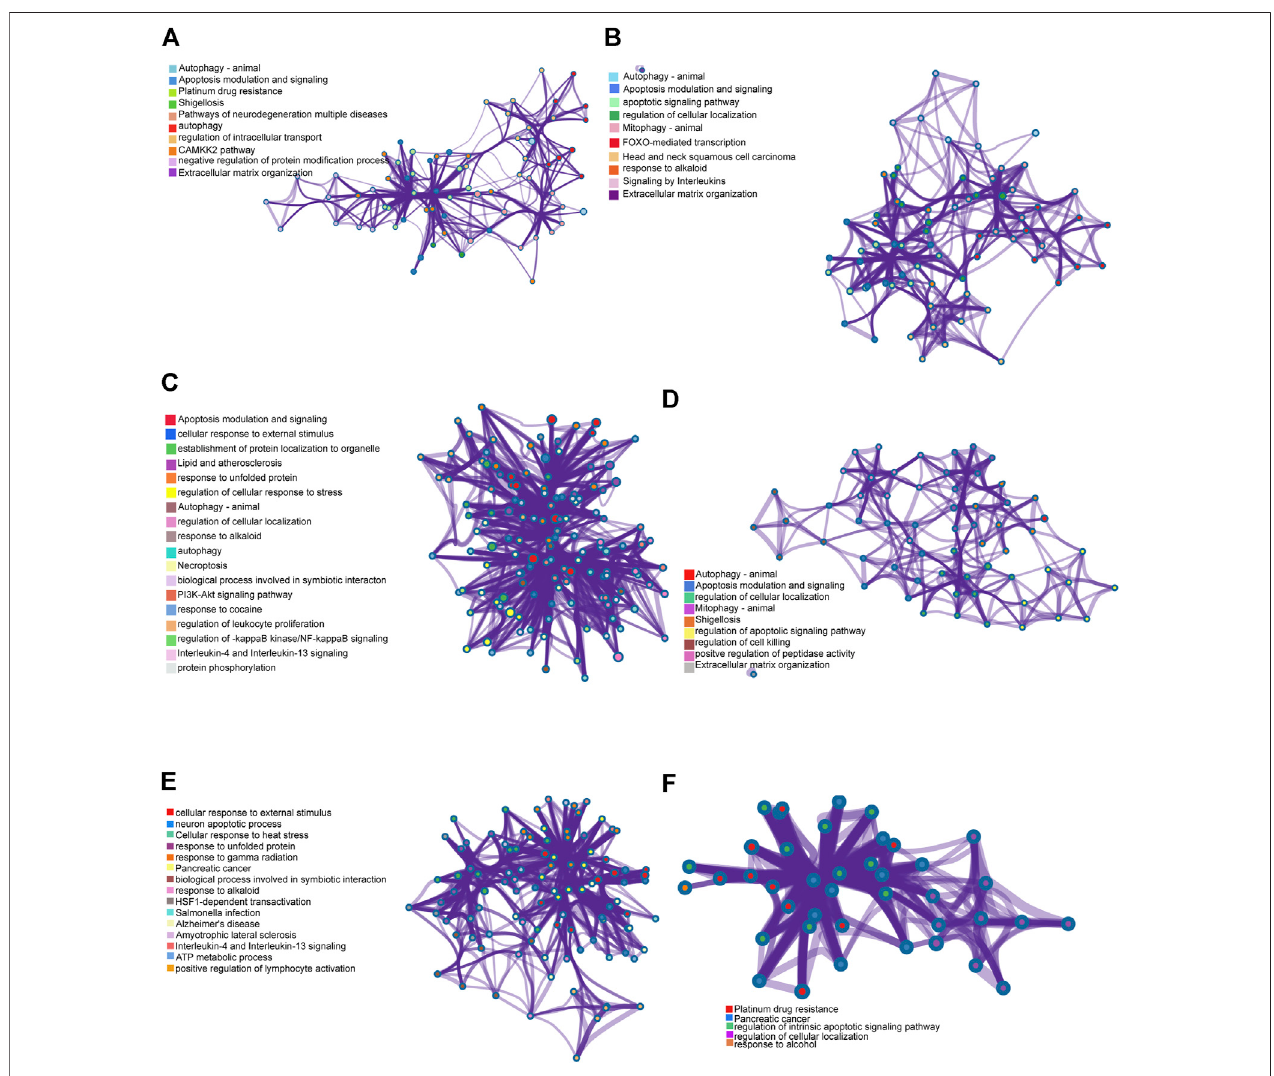
FIGURE 6 | Genes of co-expression network and their enrichment analyses. (A) Functional annotation of CTSD and its co-expressed genes. (B) Functional annotation of BAX and its co-expressed genes. (C) Functional annotation of FADD and its co-expressed genes. (D) Functional annotation of MAPK8IP1 and its co- expressed genes. (E) Functional annotation of HSPA8 and its co-expressed genes. (F) Functional annotation of BAK1 and its co-expressed genes.